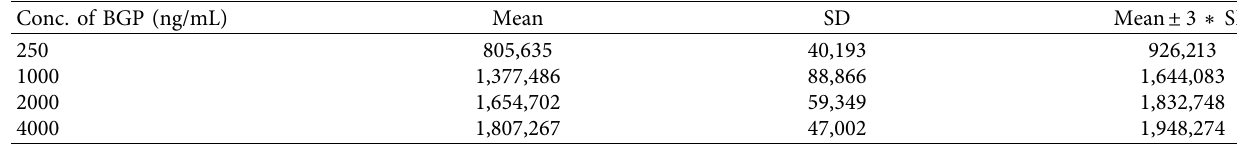
Figure 5: Comparison of the developed method and Roche method. Table 5: RLUs of concentrated osteocalcin samples.